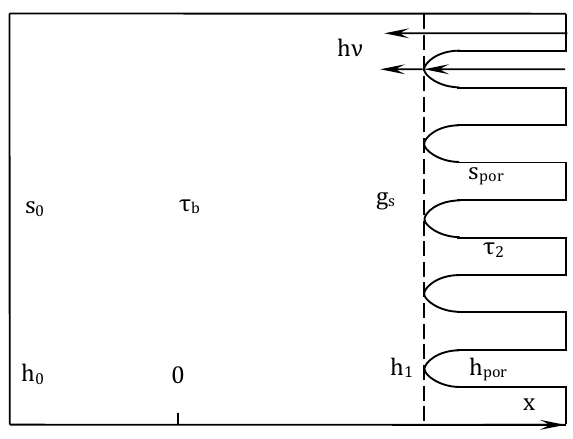
Figure 1. Schematic cross section of macroporous